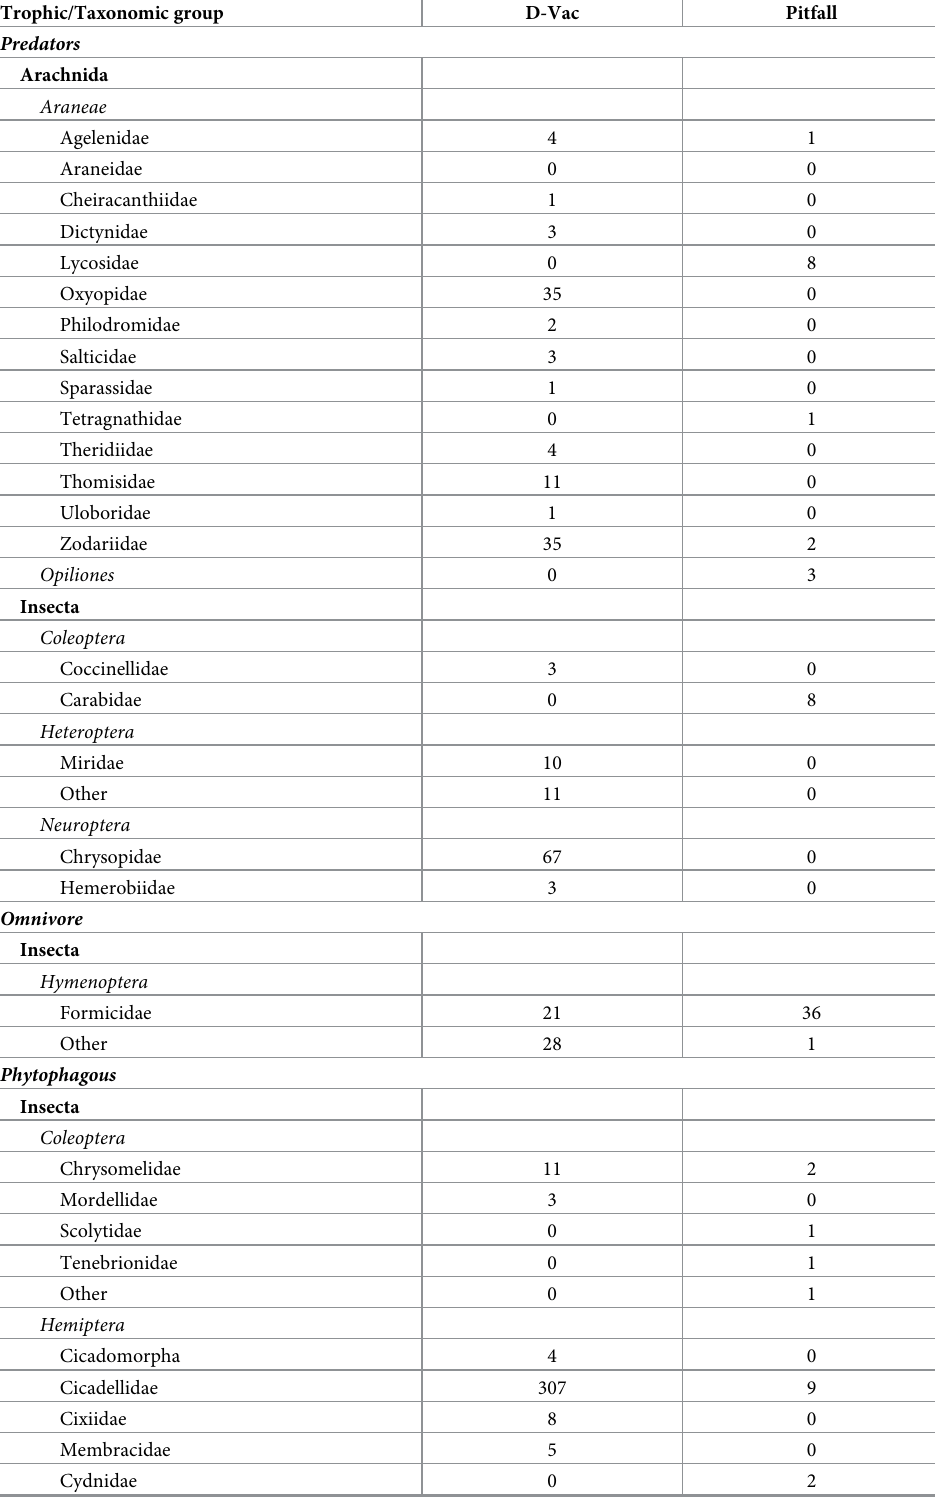
Table 1. Number of arthropods collected with D-Vac and pitfall traps. Trophic/Taxonomic